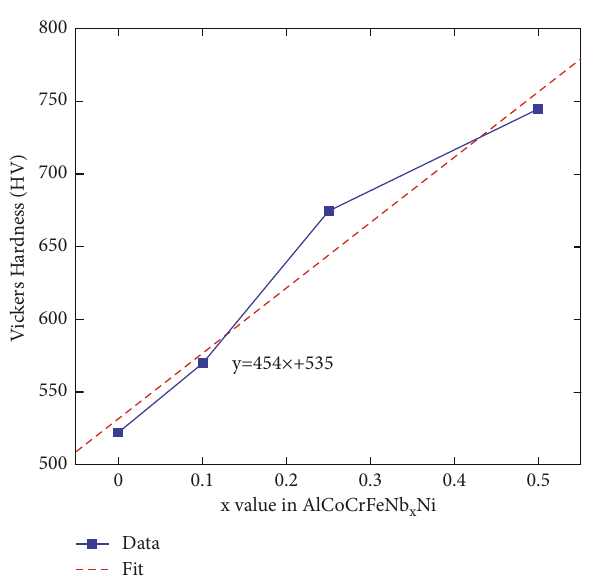
Figure 15: The hardness of AlCoCrFeNb Contents ( x � 0, 0.1, 0.25, and 0.5) [8].